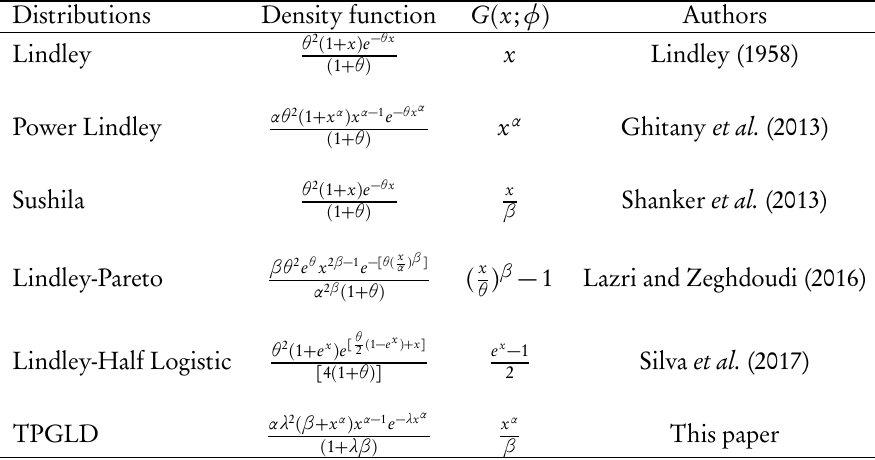
Distributions and corresponding G ( x ; φ )